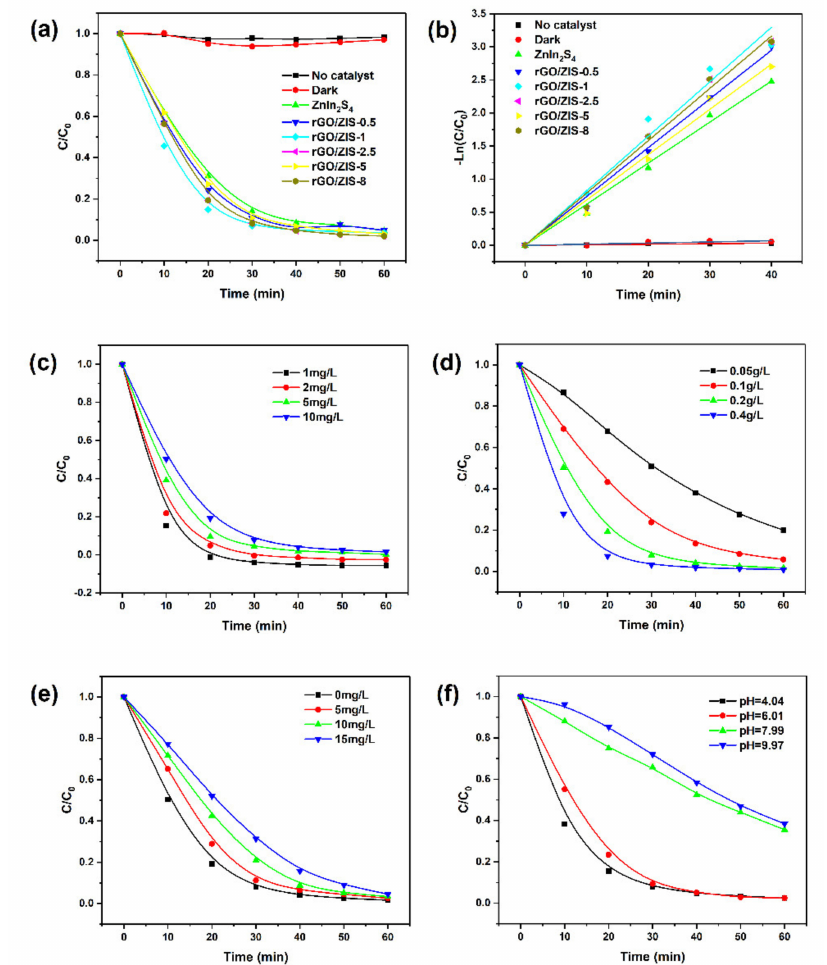
Figure 5. ( a ) Photocatalytic degradation of NPX with di ff erent photocatalysts and ( b ) plots of − ln(C / C 0 ) vs irradiation time; E ff ects of initial concentration of NPX ( c ), photocatalyst dosage ( d ), HA ( e ) and pH ( f ) on NPX photodegradation by rGO / ZIS-1. Reaction conditions: [NPX] = 10 mg · L − 1 , [photocatalyst] = 0.2 g · L − 1 , natural pH for ( a ), ( b ), ( c ), ( d ), and ( e ), λ > 420